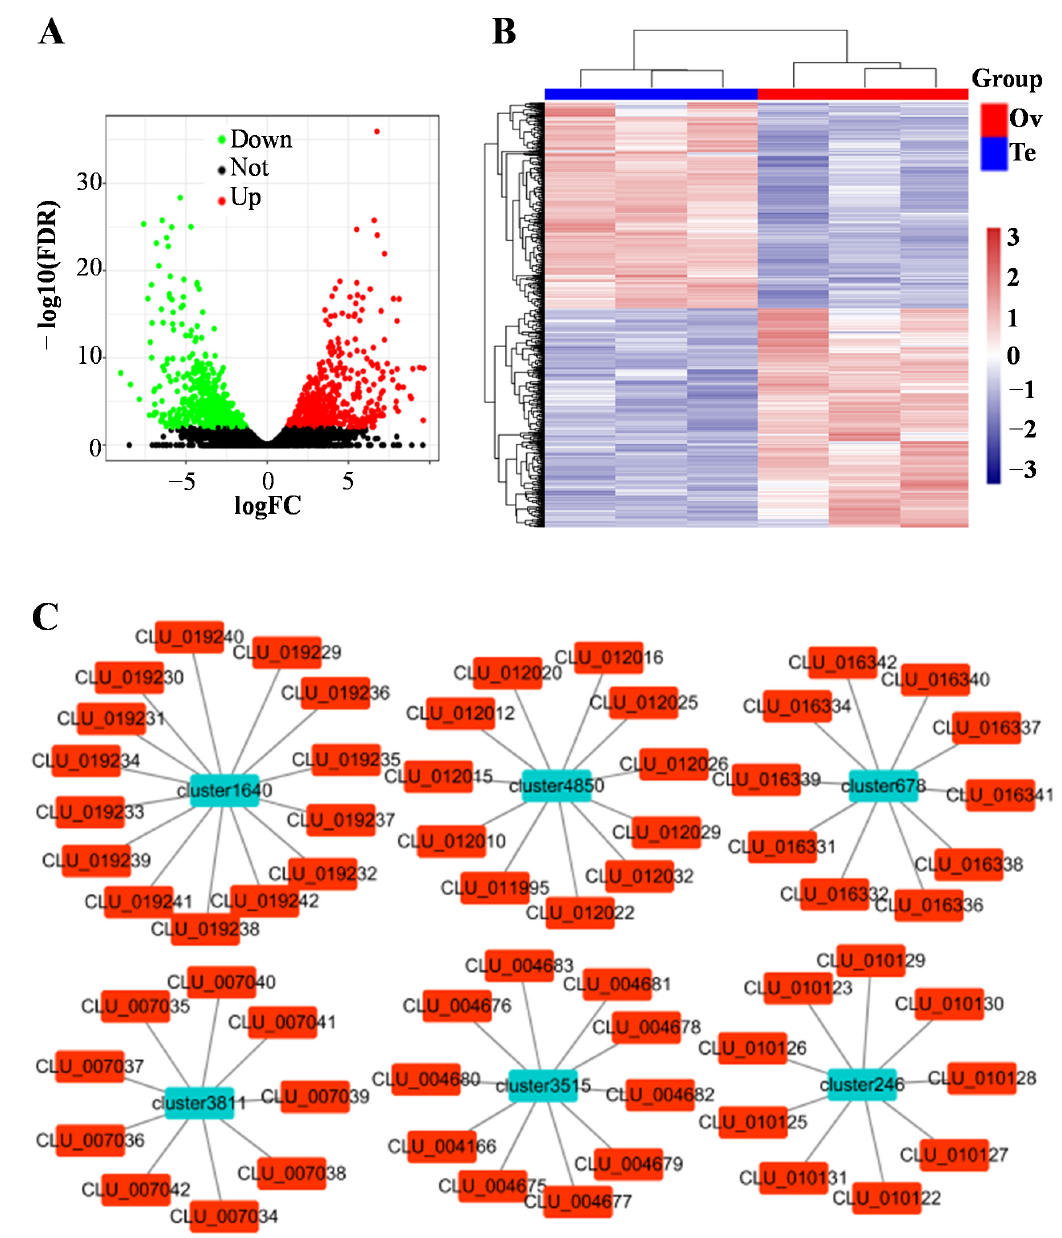
Figure 6. Differential expression analysis of piRNA clusters. ( A ) Volcanic plot displaying differentially expressed piRNA clusters between testes and ovaries. ( B ) Heatmap showing differentially expressed piRNA clusters between testes (Te) and ovaries (Ov). Columns indicate samples and rows indicate piRNAs. Red indicates high expression and blue indicates low expression. (C) Network between piRNA clusters and their nearby genes. Only the top six piRNAs with the largest number of adjacent genes are